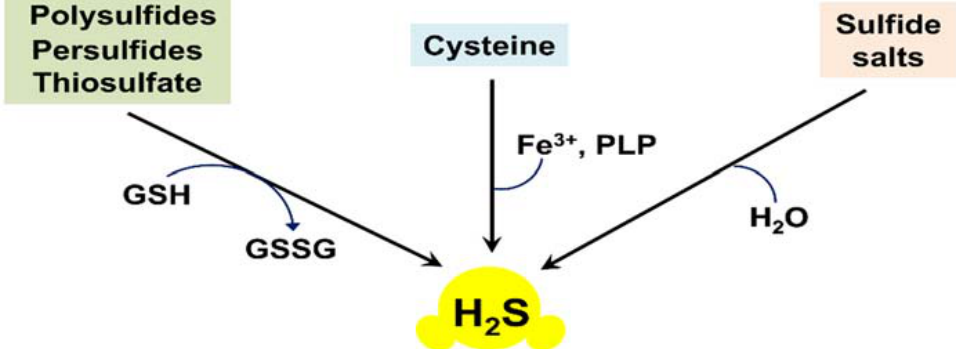
Figure 2. Non-enzymatic endogenous production of H 2 S in mammalian tissues.